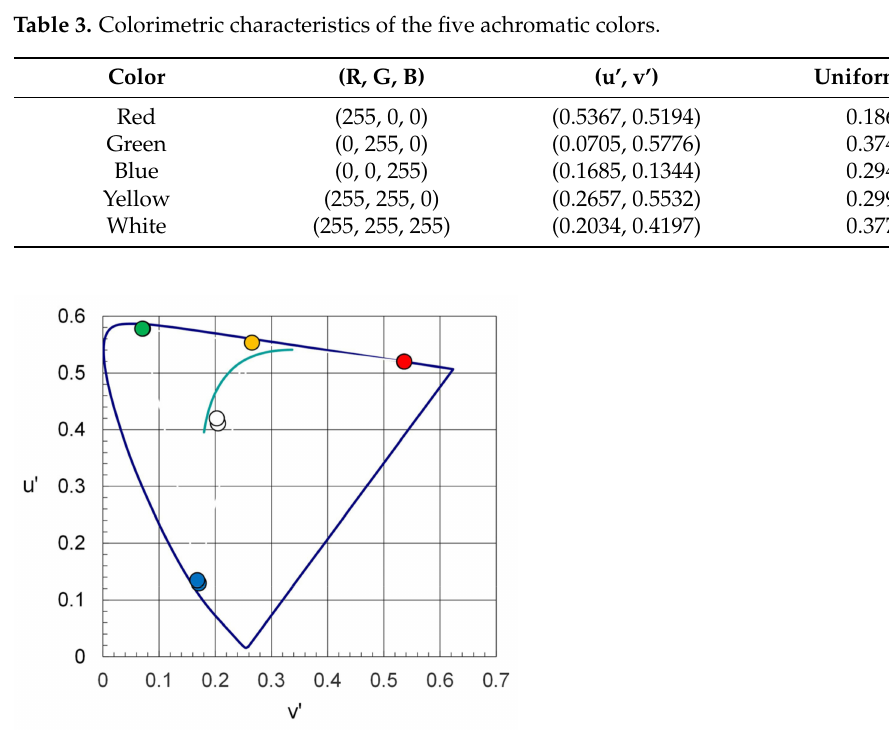
Figure 3. The CIE 1976 u’, v’ chromaticity coordinates of the LED color